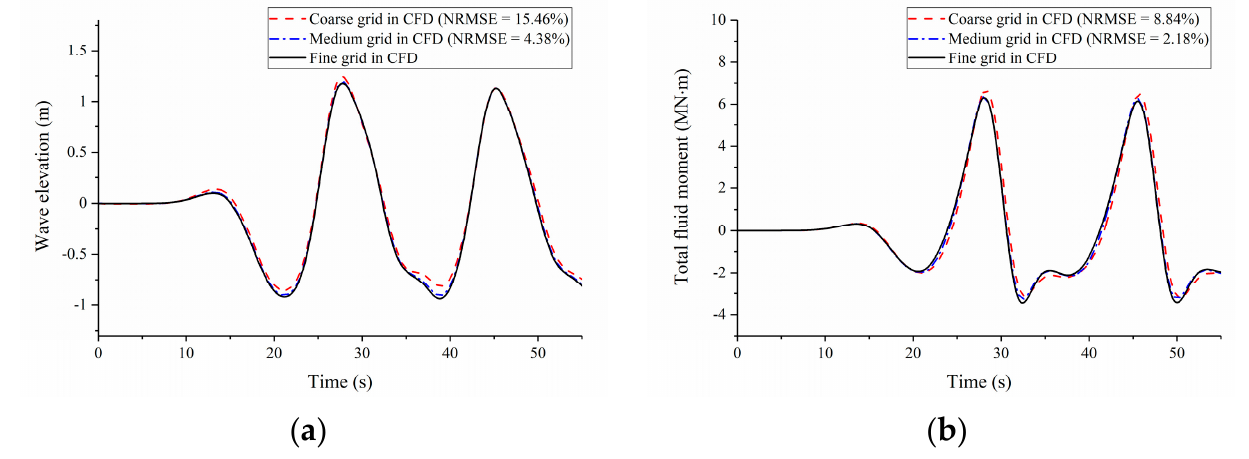
Figure 8. The comparison of the results for different element sizes in CFD: ( a ) time–history wave elevation at 20 m in front of the flap; ( b ) time–history total fluid moment on a fixed flap under a representative regular wave ( A i = 1 m and T = 17.5 s).